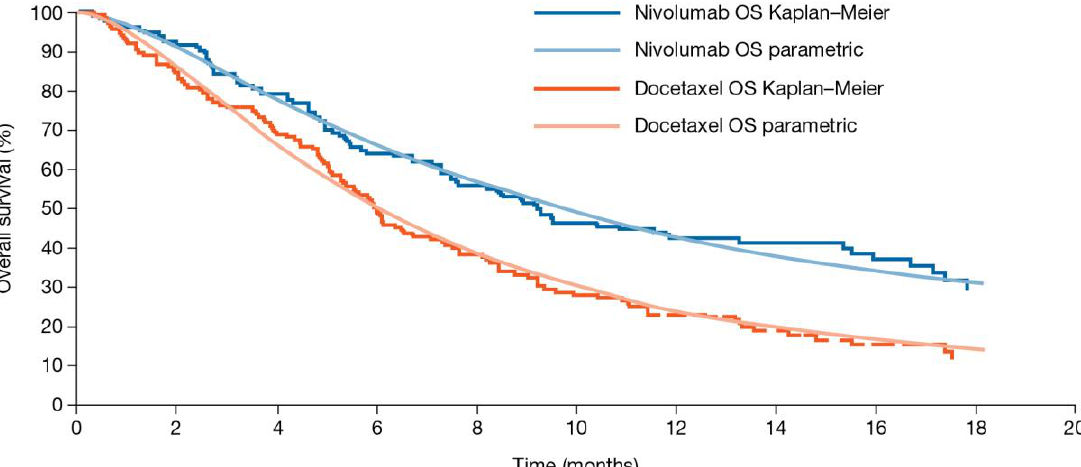
Figure 2: Parametric curves for OS over 18 months (squamous analysis; CheckMate 017) OS = overall